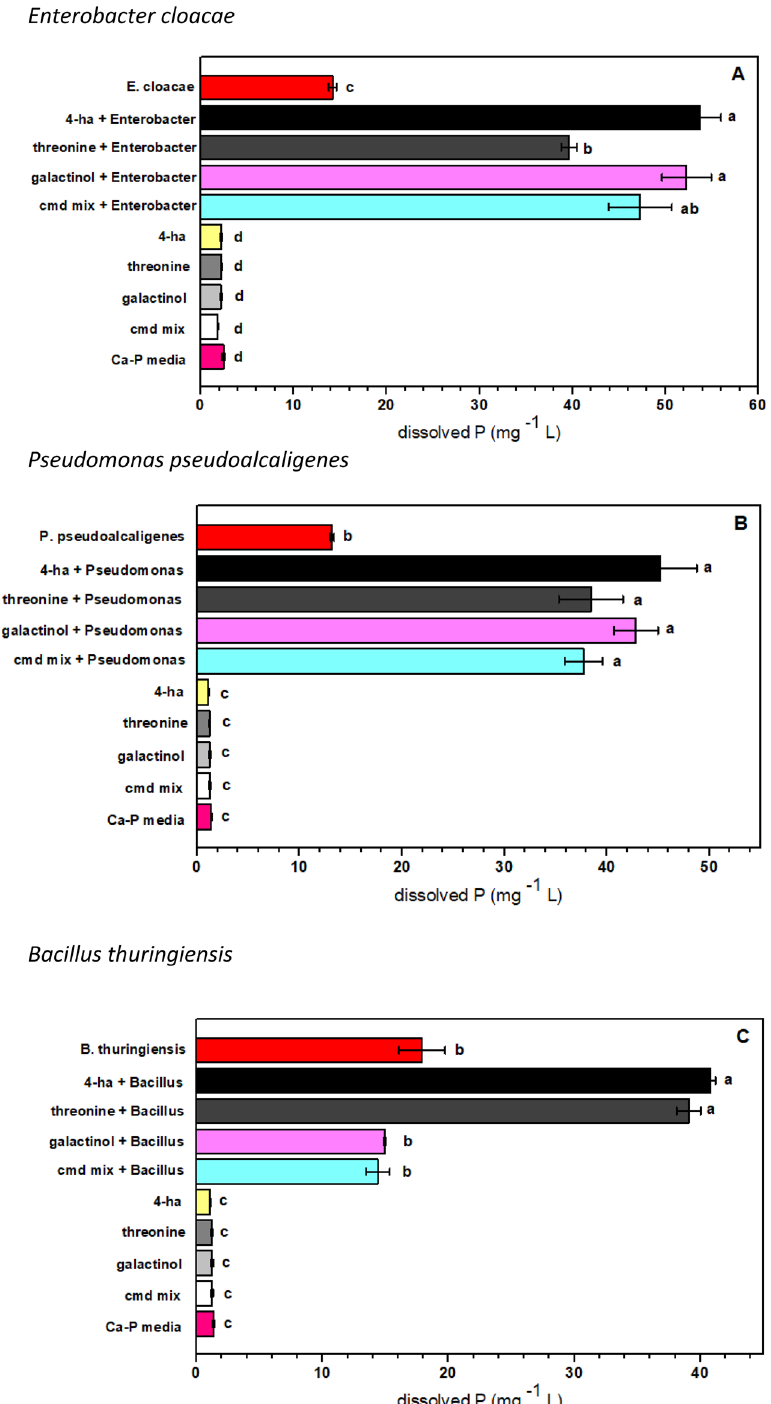
Figure 3. Effect of individual root exudates on dissolved P by phosphorus solubilizing bacteria in a calcium phosphate inorganic media. Each panel corresponds to ( A ) Enterobacter cloacae , ( B ) Pseudomonas pseudoalcaligenes , ( C ) Bacillus thuringiensis , ( D ) Bacteria consortium. A two-ways ANOVA was performed to compare the effect of root exudates on bacteria. Tukey’s HSD test for multiple comparisons show significant differences. Different letters denote statistical significance among treatments ( p-value <